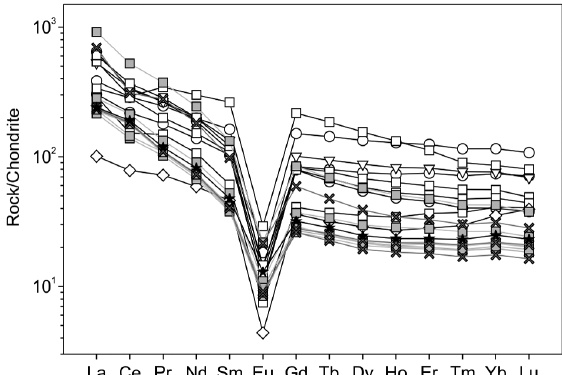
Figure 15 - Chondrite-normalized REE patterns for selected samples of the Quiriri and Papanduva Plutons, Morro Redondo Complex. Normalizing factors after Boynton (1984). Symbols as in Fig.